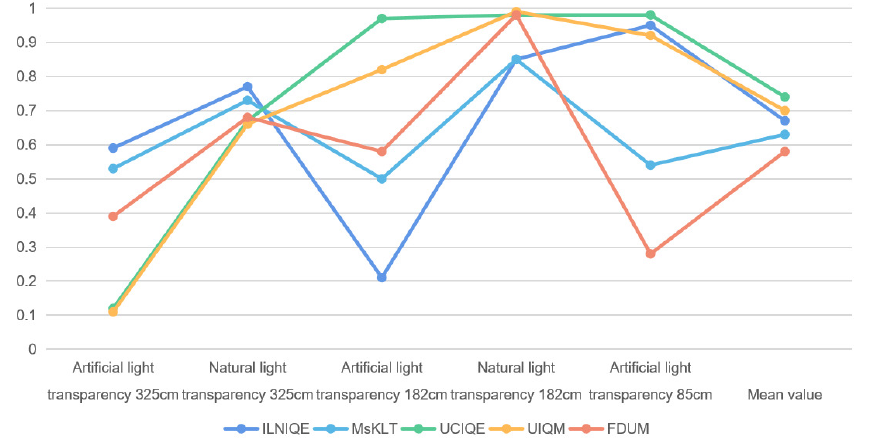
Figure 6. PLCC curve between IQA predict results and ∆ E ∗ ab